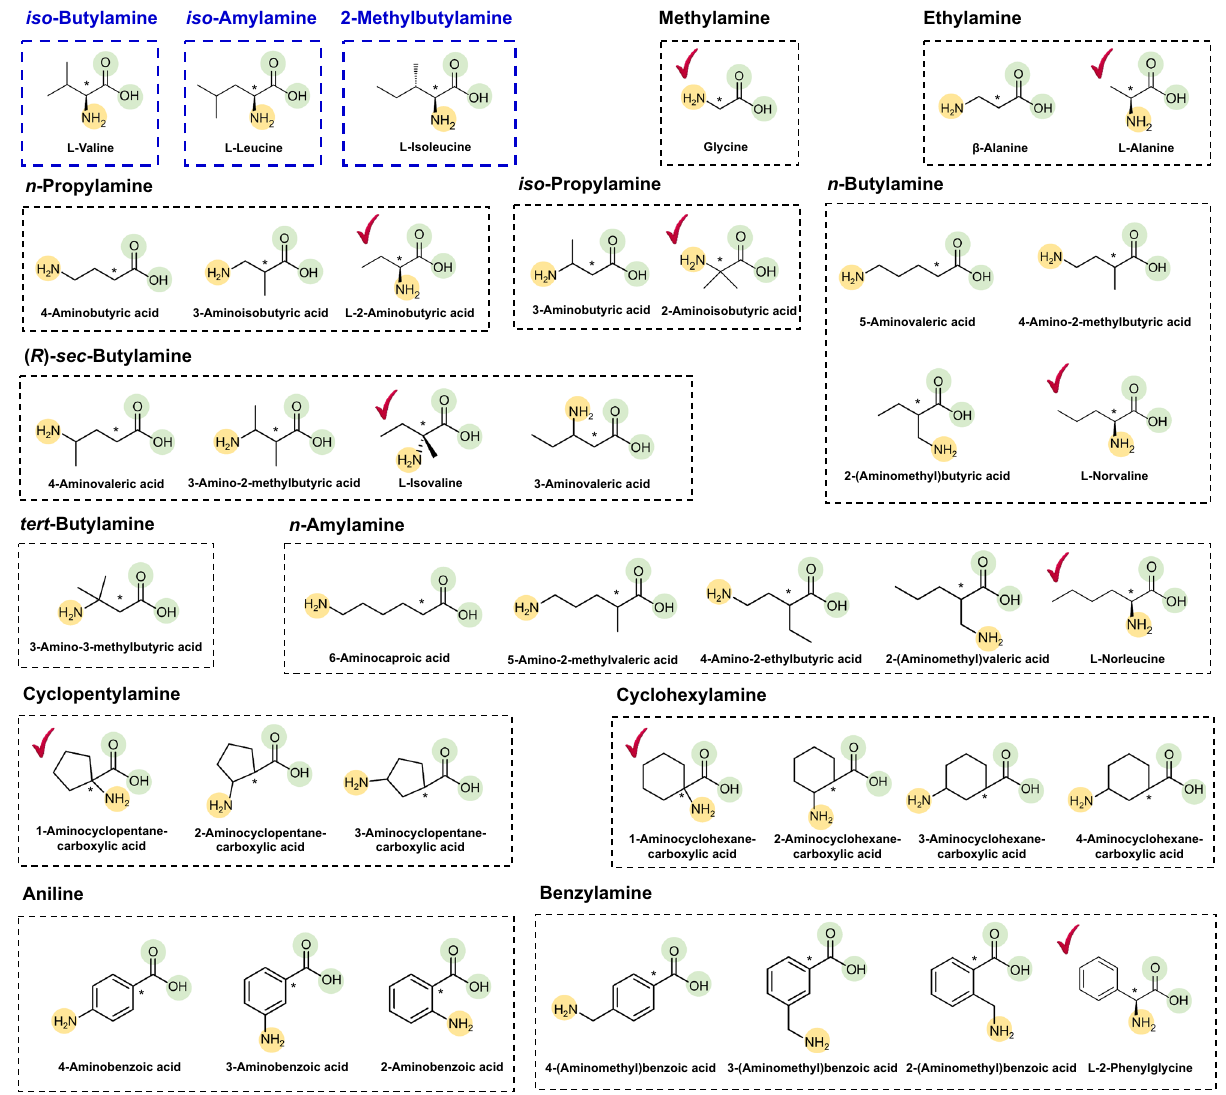
Fig. 2 Relative position of functional groups in the predicted amino acid precursors of 12 SCPAs in comparison with the previously reported substrates of VlmD. Amine and carboxylic groups in the amino acid precursors predicted using retrobiosynthesis for each SCPA are presented with yellow and green circles, respectively, in a dotted black box. Reaction center carbon atoms that are subject to chemical transformations are marked with asterisks. Precursors having the same relative position of functional groups, compared with the previously reported VlmD substrates 28 in dotted blue boxes, are presented with a check